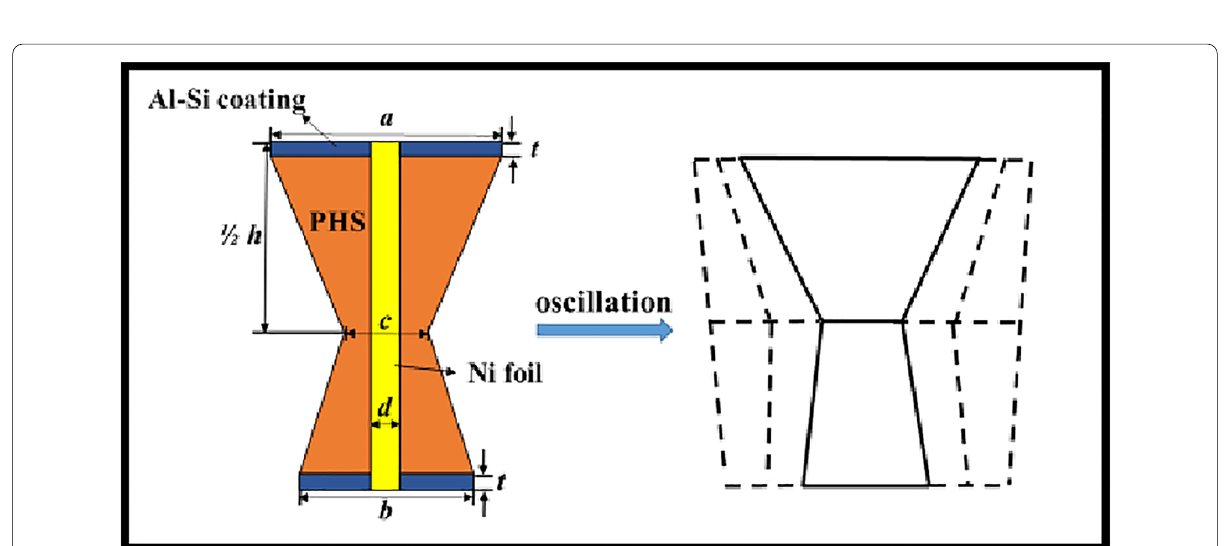
Figure 11 Simplified weld shape with increasing oscillation